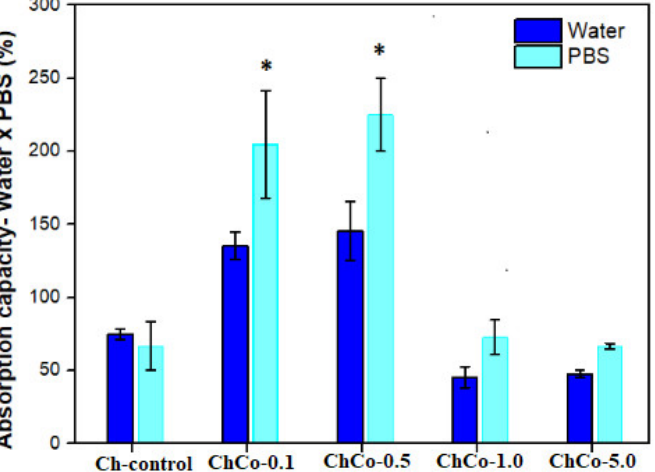
Figure 4. Evaluation of the absorption capacity of fluids of polymeric membranes of Ch-control without chitosan, and incorporated with copaiba oil (ChCo-0.1; ChCo-0.5, ChCo-1.0, ChCo-5.0) immersed for 24 h in water and PBS. The asterisk indicates the statistical difference between the control group and the group with oil obtained in the Tukey test.